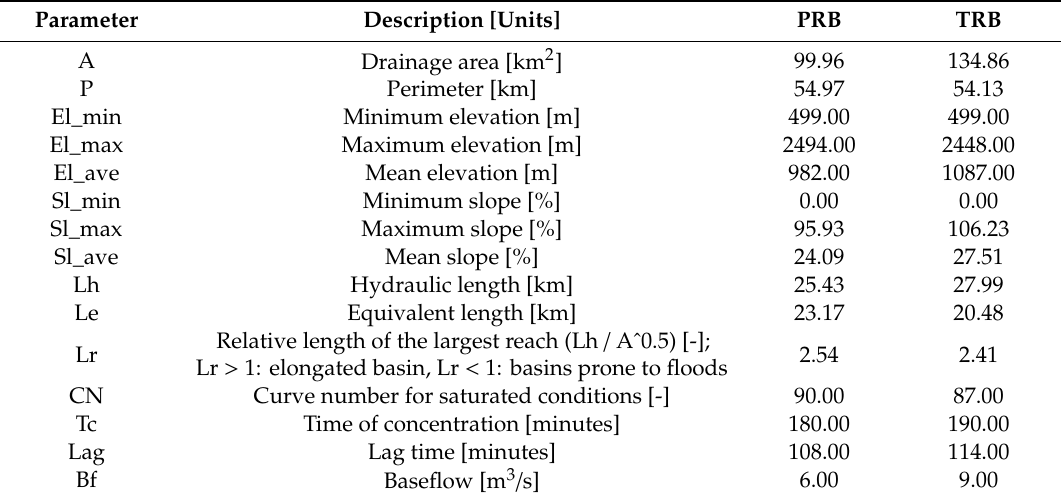
Table 1. Morphological and hydrological parameters of PRB and